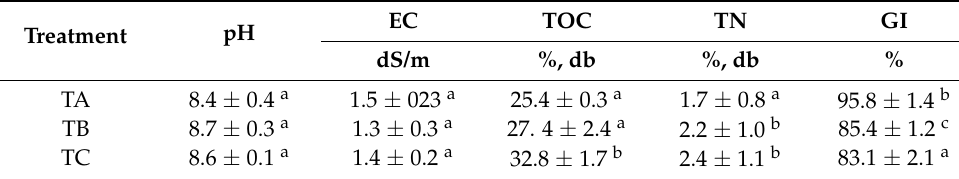
Table 1. Physicochemical characteristics of the obtained compost product.